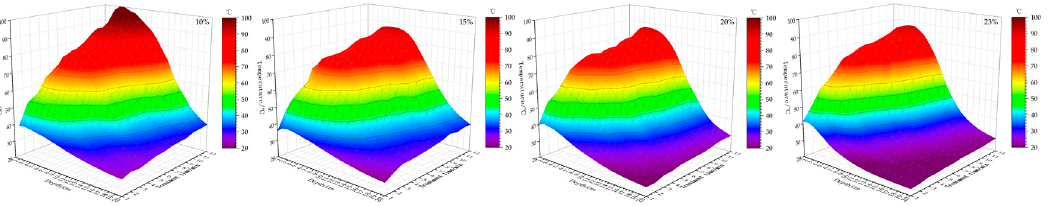
Figure 28. Fitting surface of the loess internal temperature with irradiation time and soil depth.